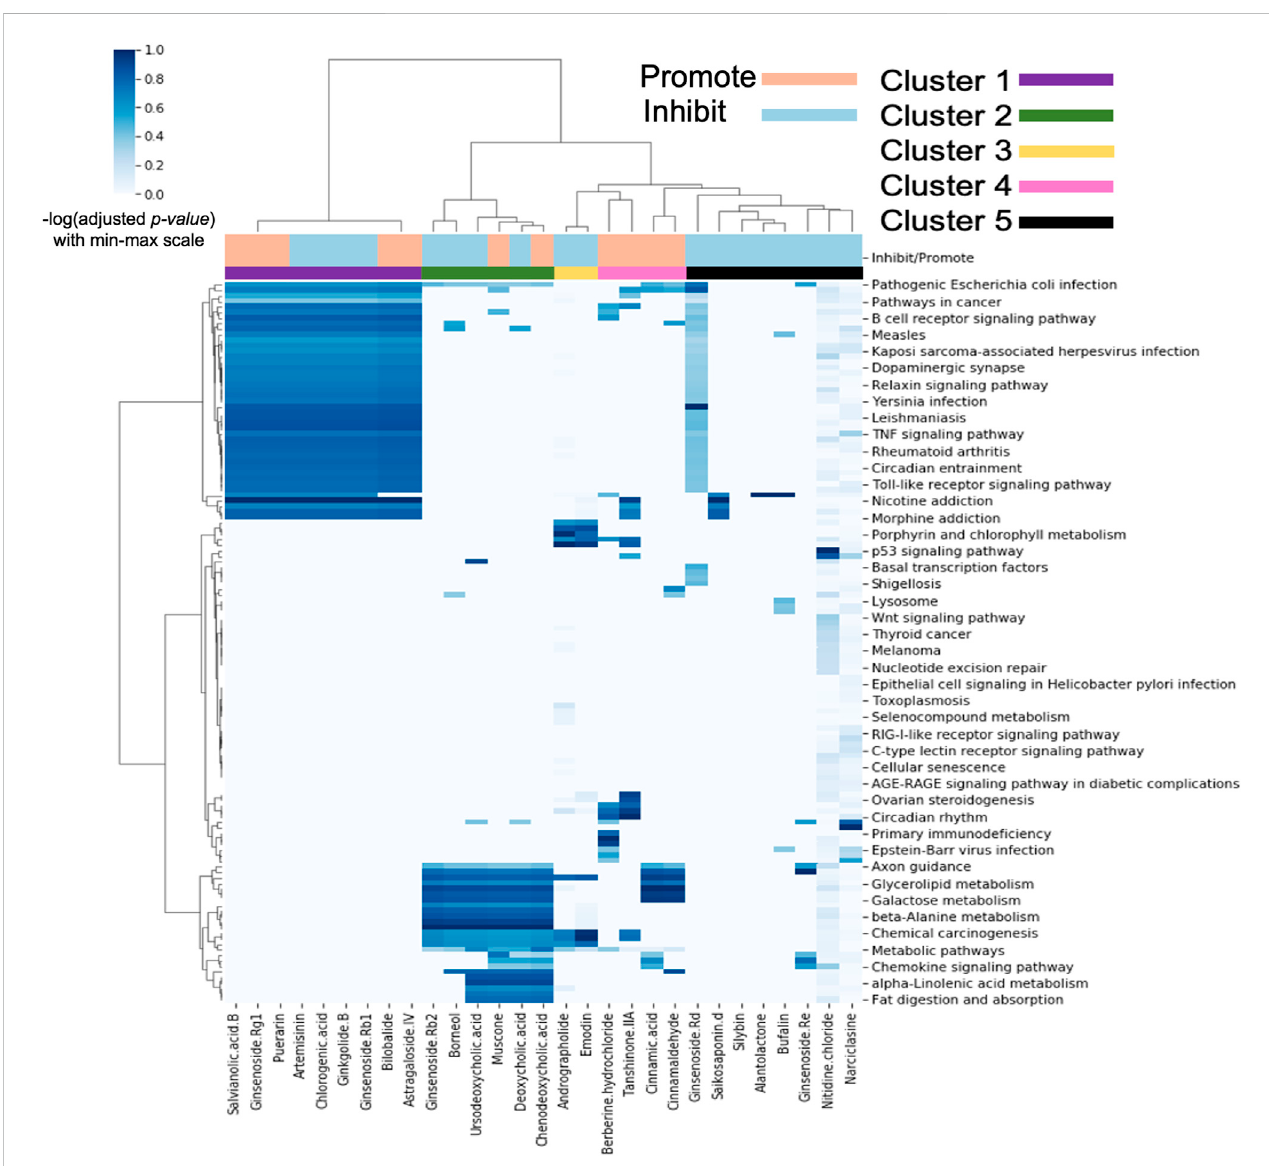
FIGURE 3 Pathway enrichment signatures for individual pro-angiogenic (Promote) or anti-angiogenic (Inhibit) metabolites derived from TCM. Individual metabolites was clustered into fi ve groups labelled with different colours (Cluster 1 –